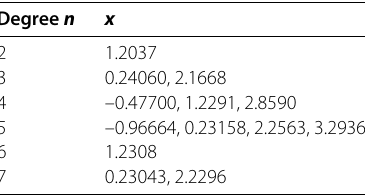
Table 2 Approximate solutions of T ( k ) n , q ( x ) = 0, k = 3, q = 1/2 Degree n